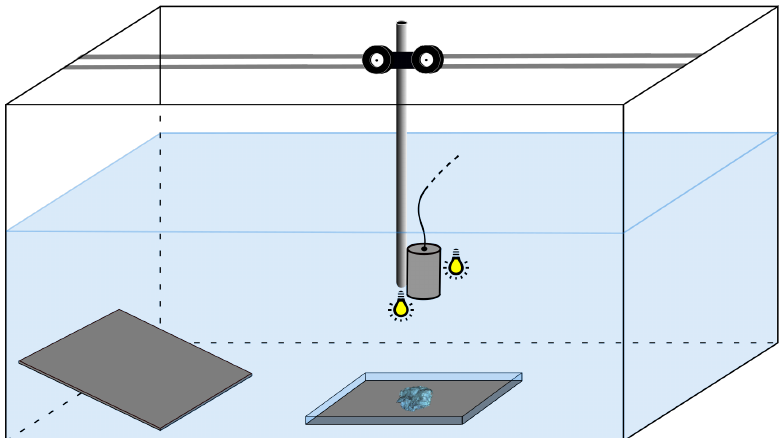
Figure 2. Illustration of the laboratory tank setup. The illustration depicts the tank, moving camera rig, hyperspectral camera, halogen lamps, samples in a submersible crate and tilted calibration